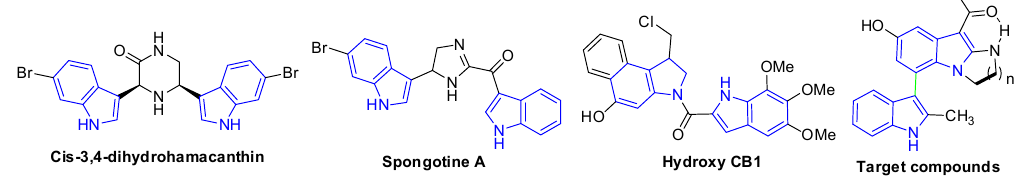
Figure 1. Biologically active bisindole derivatives.